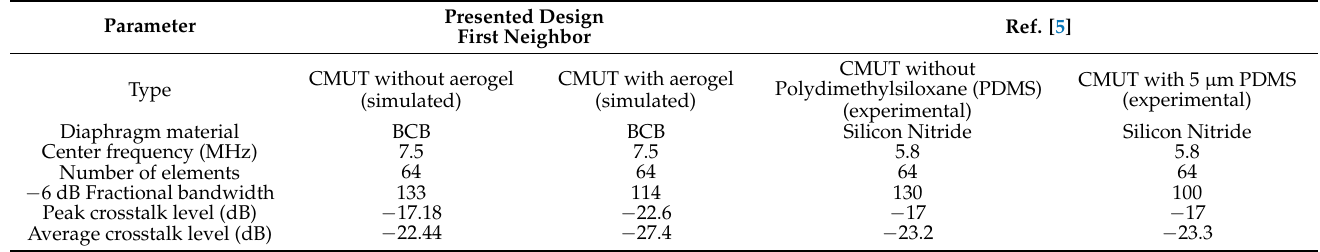
Table 6. Experimental validation of the effectiveness of the aerogel layer in crosstalk reduction in CMUT arrays [21]. Parameter